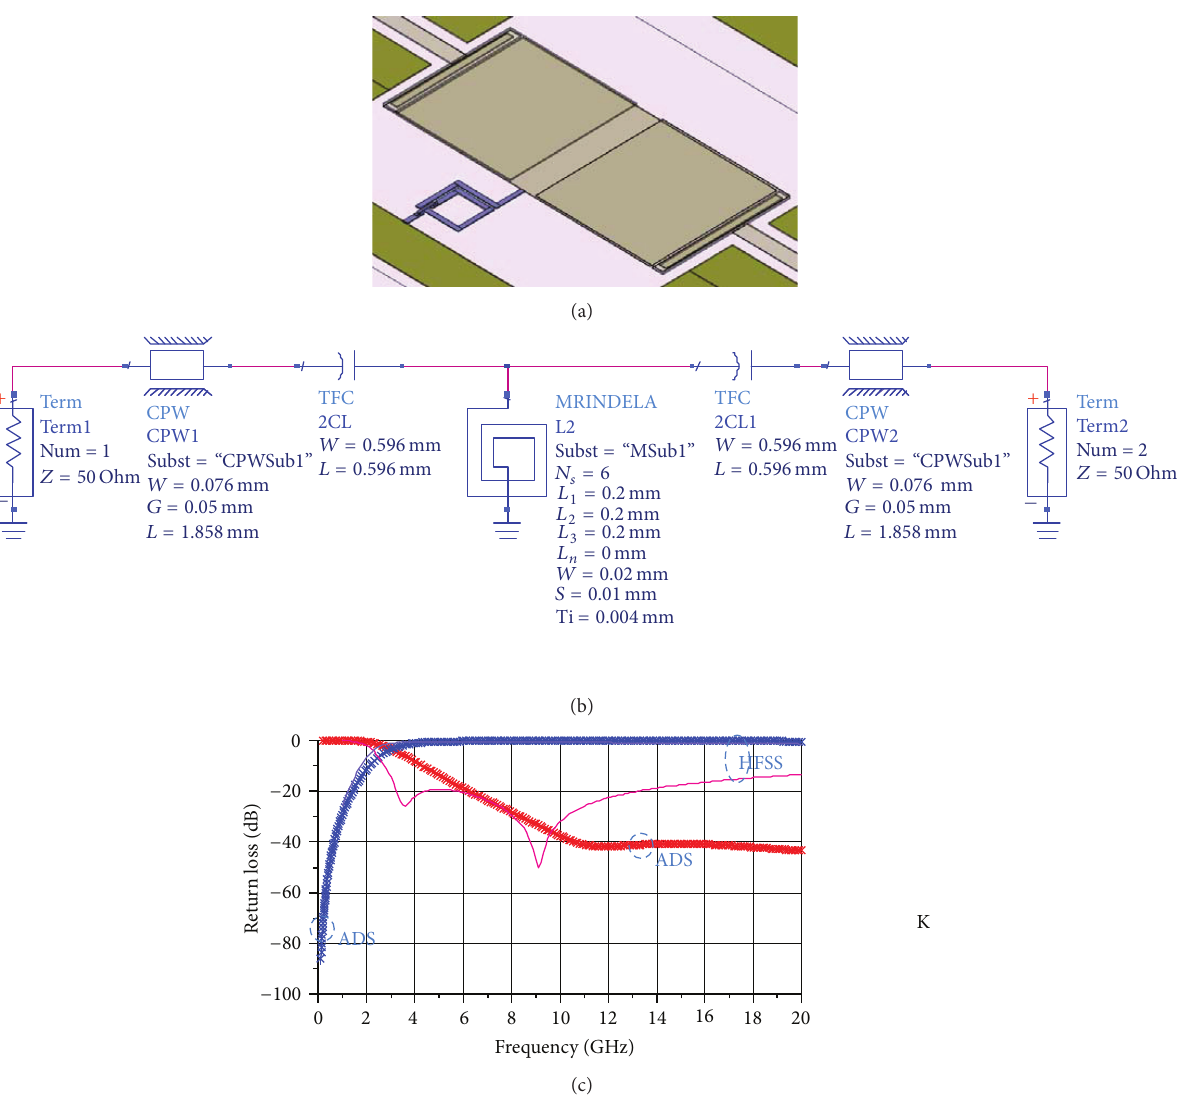
F 4: Performance of the CRLH-TL structure according to ADS and HFSS: (a) full-wave simulation of the CRLH-TL in HFSS; (b) electric inductor circuit model for the inductor in ADS; (c) simulated S 11